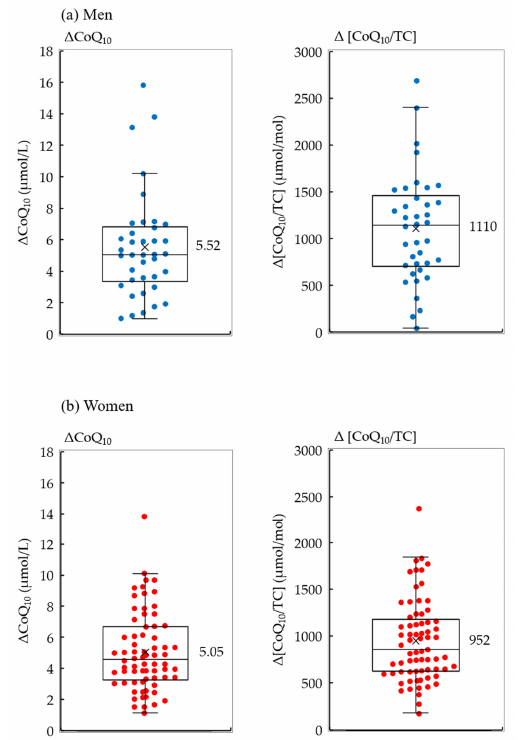
Figure 2. Serum ∆ CoQ 10 and ∆ [CoQ 10 /TC] levels after 1 year of supplementation. Beeswarm box- plots of ∆ CoQ 10 and ∆ [CoQ 10 /TC] for ( a ) men and ( b ) women. The bottom of the box is the 25th percentile, the line that intersects the box is the median, the multiplication sign within the box is the mean, and the top of the box is the 75th percentile. Whiskers above and below the box represent the 10th and 90th percentiles, and the points above and below the whiskers indicate the outliers. Differences between the two groups were analyzed using Welch’s t -tests ( p < 0.05). ∆ CoQ 10 , increased serum coenzyme Q 10 ; ∆ [CoQ 10 /TC], cholesterol-adjusted increased serum CoQ 10 .